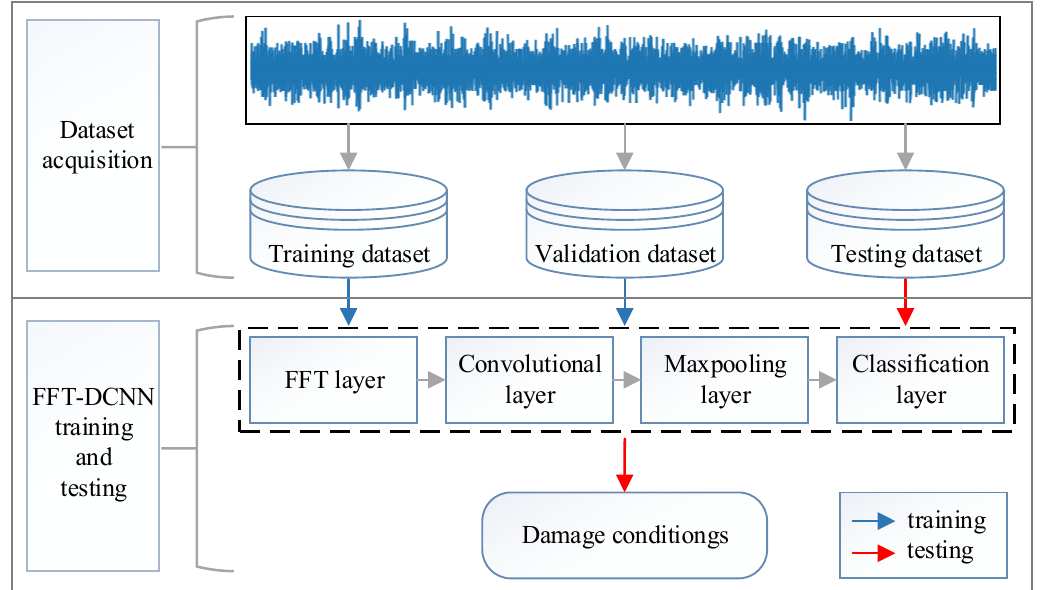
Figure 3. Flowchart of the proposed FFT-DCNN for structural damage detection .